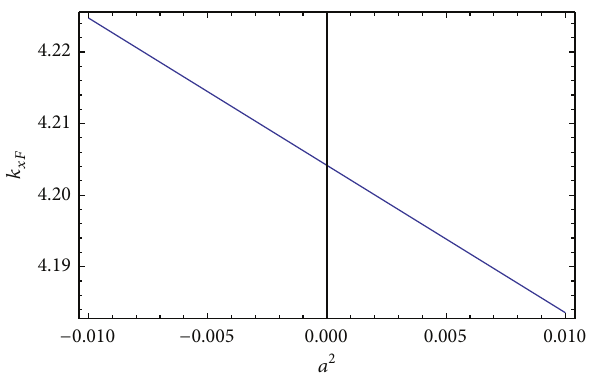
Figure 6: The plot of 𝑘 𝑥𝐹 varies as 𝑎 2 < 0 .